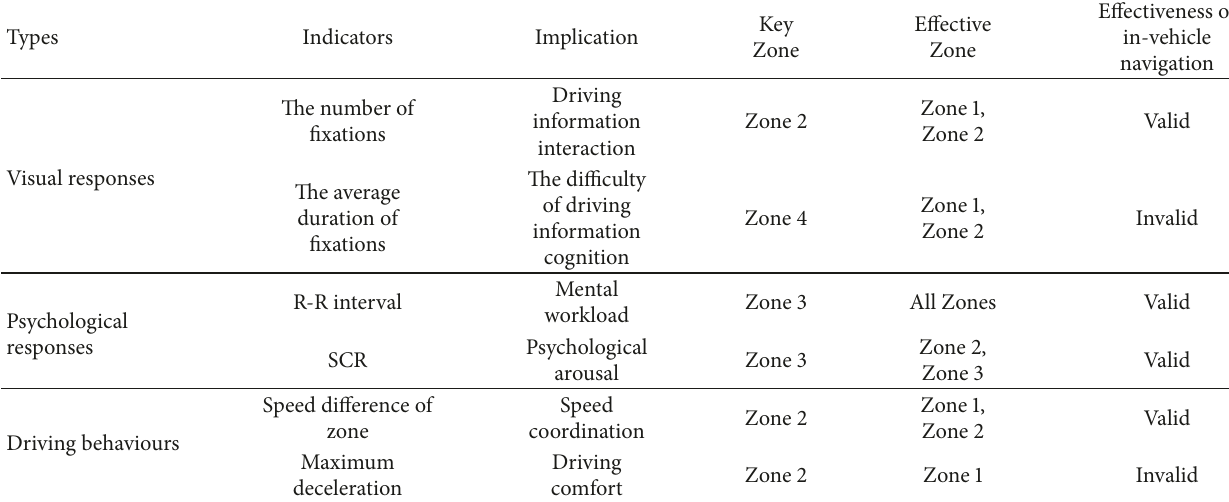
Table 8: Evaluation results of the effectiveness of in-vehicle